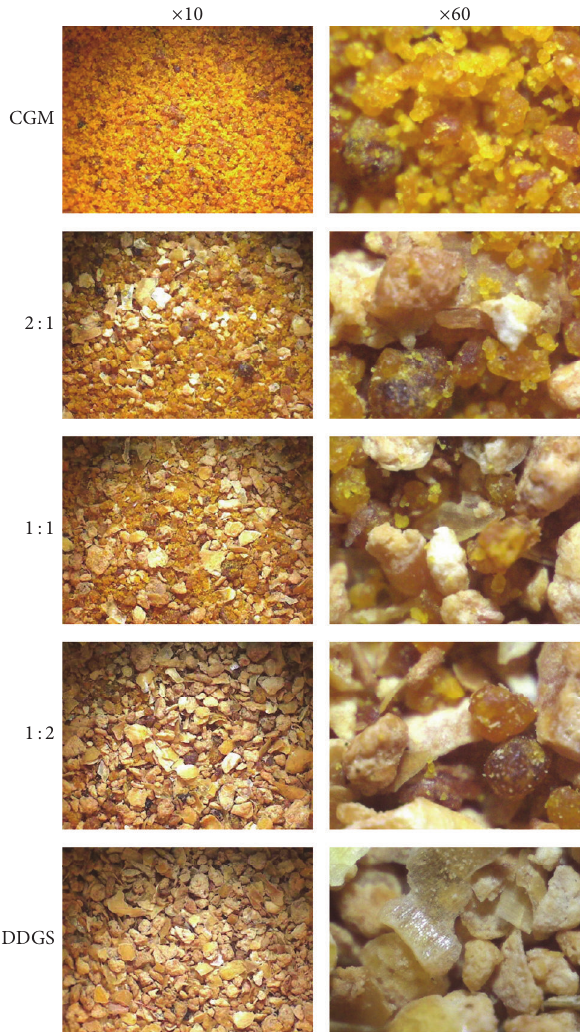
Figure 2: Optical images of CGM and DDGS particles at × 10 and × 60 magnification before denaturing or extrusion.